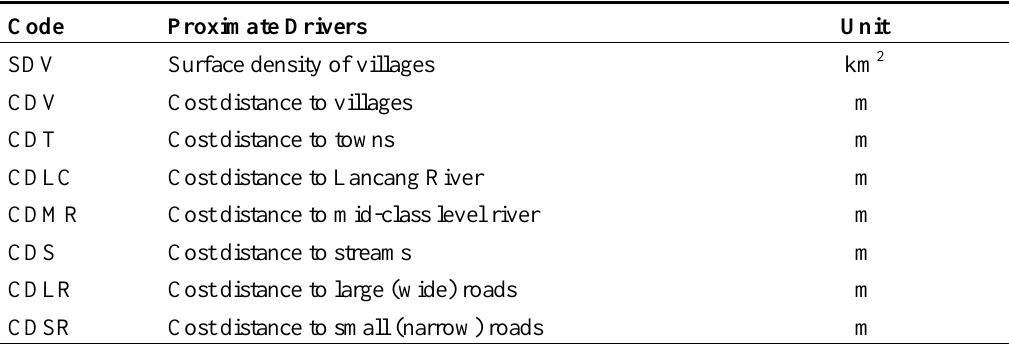
Table 5. Human disturbance